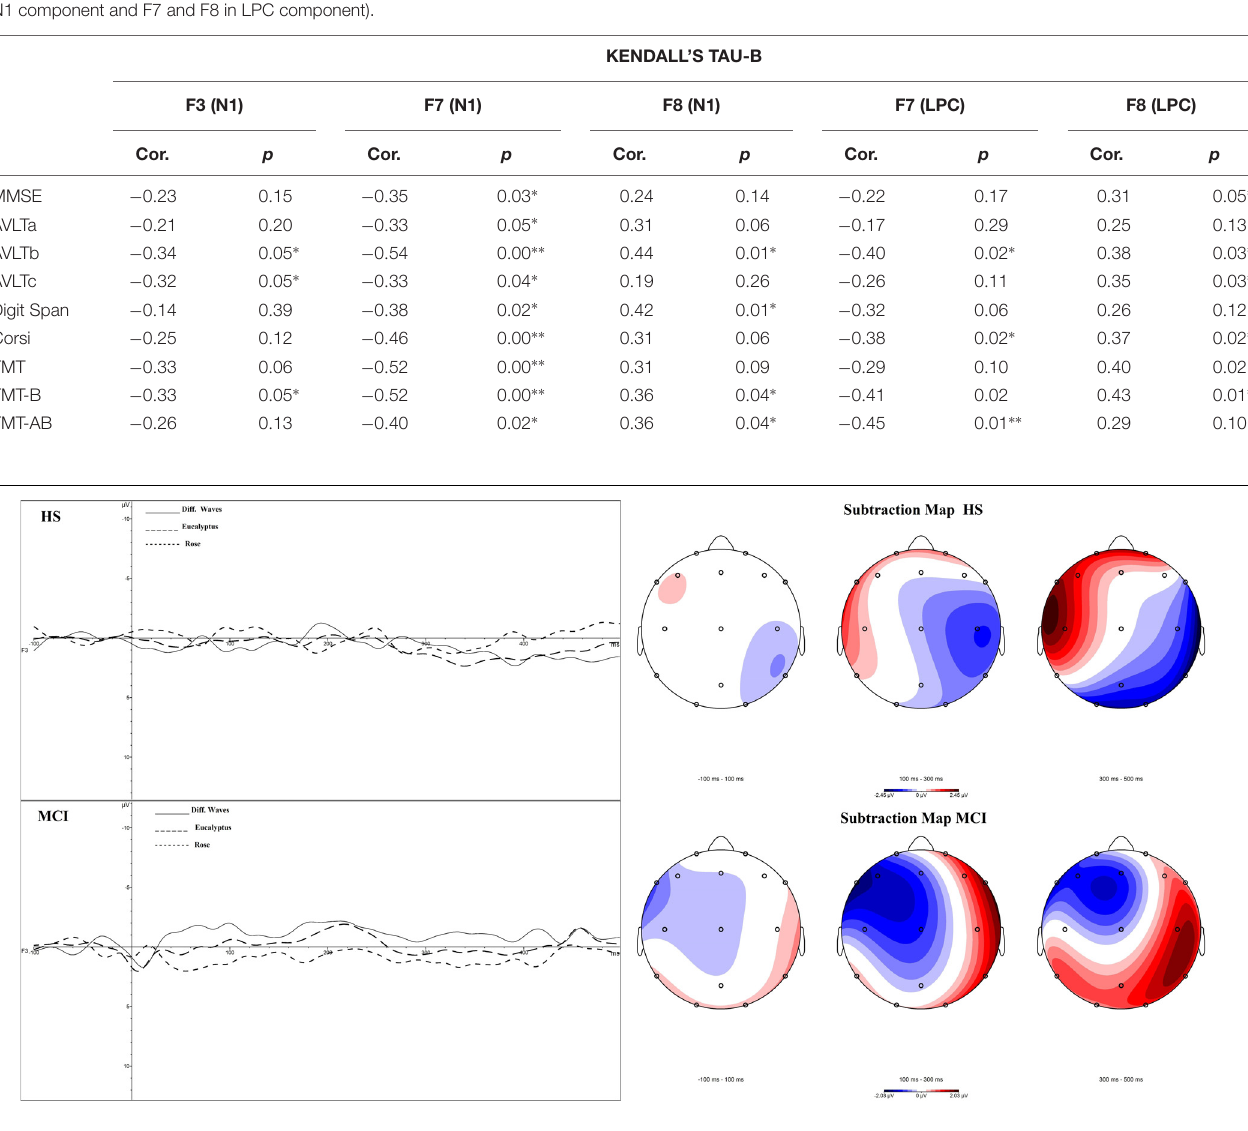
FIGURE 5 | Subtraction OERP components and Map in HS and MCI